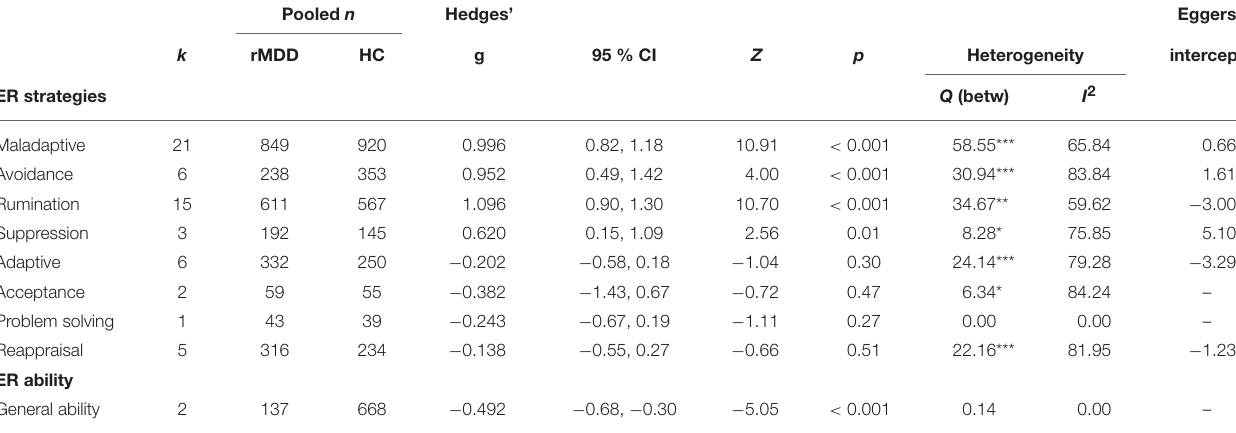
TABLE 2 | Synthesis of results from studies with participants in remission from